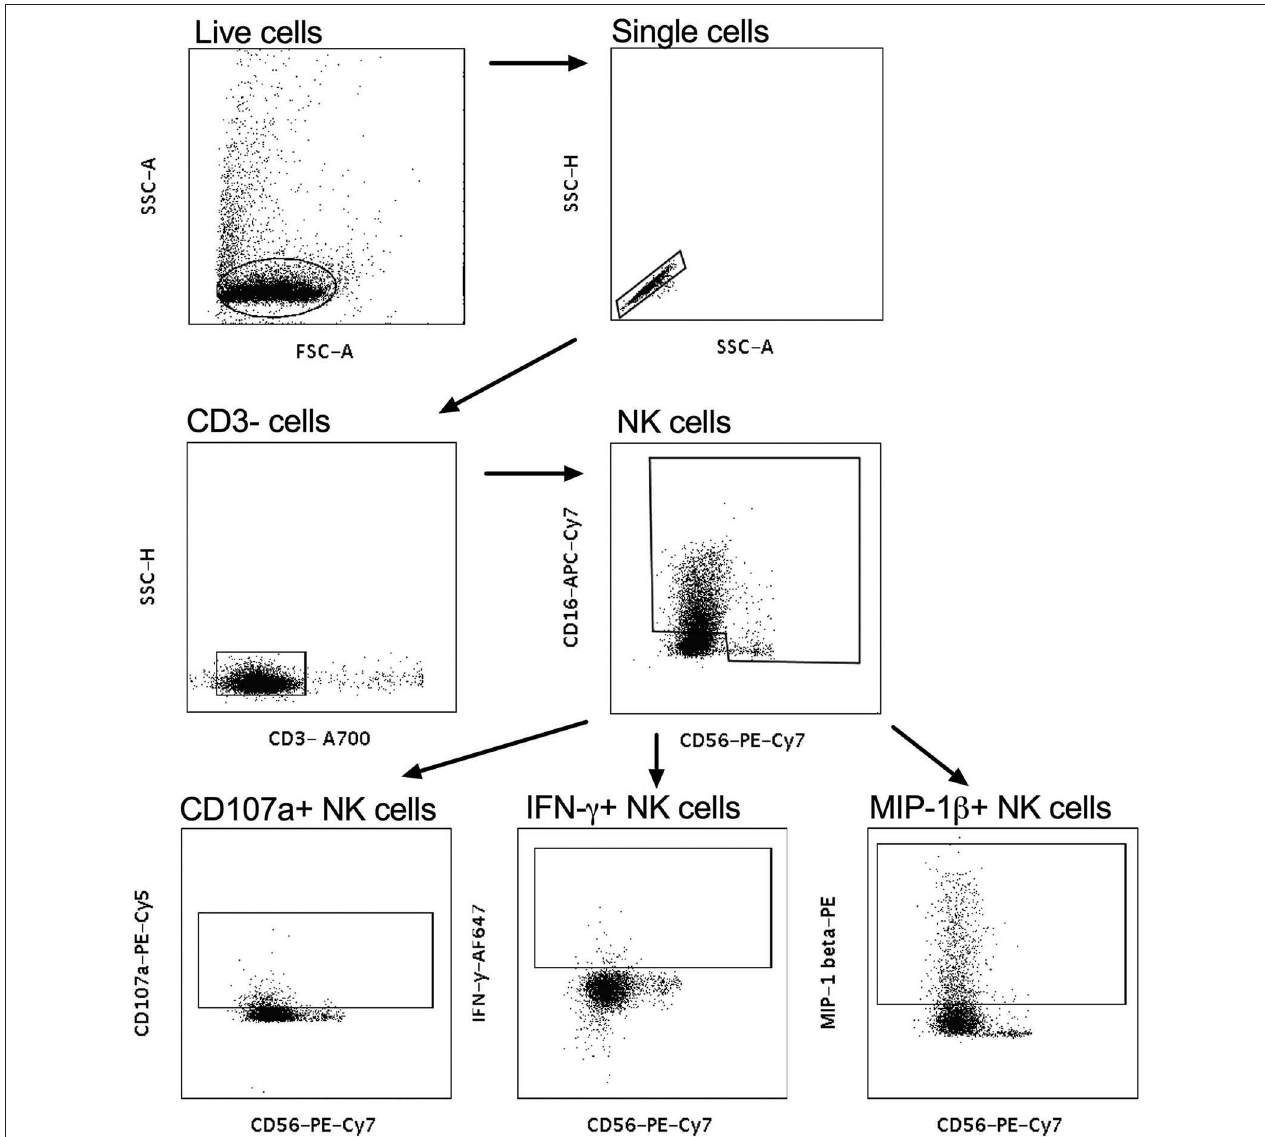
FIGURE 2 | Gating strategy for NK-cell-activated antibody-dependent cellular cytotoxicity (ADCC). CD3 − cells were gated on and subsequently CD56 + CD16 + NK cells were selected. CD56 + CD107a + , CD56 + IFN- γ + , and CD56 + MIP-1 β + were used to identify cytotoxic markers and antiviral cytokines for activated NK cells.